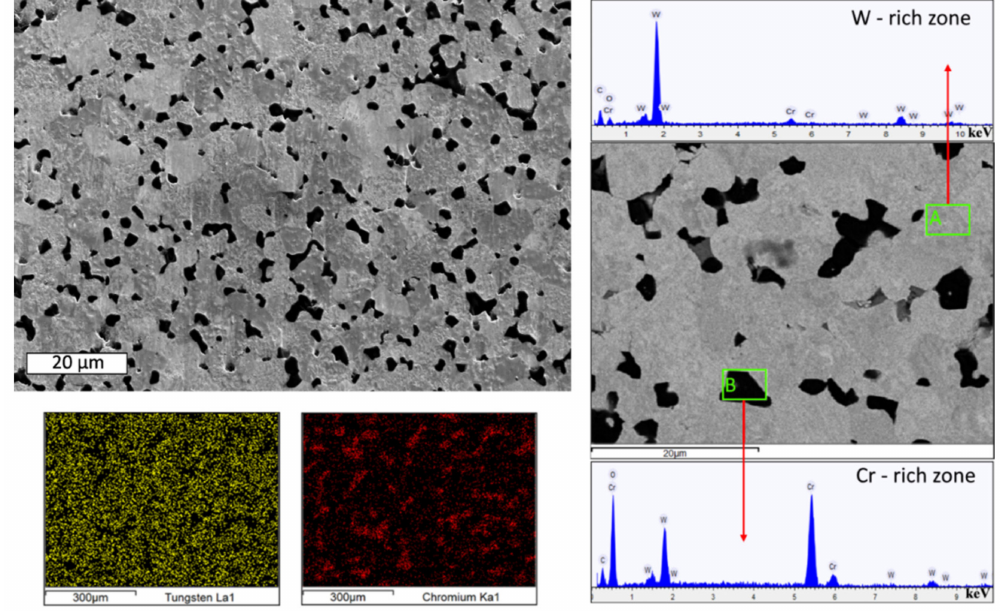
Figure 6. Upper left: SEM observation of the WCr6 sintered sample (2000 ◦ C—5 (cid:48) ). Right: EDX analysis of W-rich and Cr-rich regions; bottom left: EDX mapping on a large-scale of the